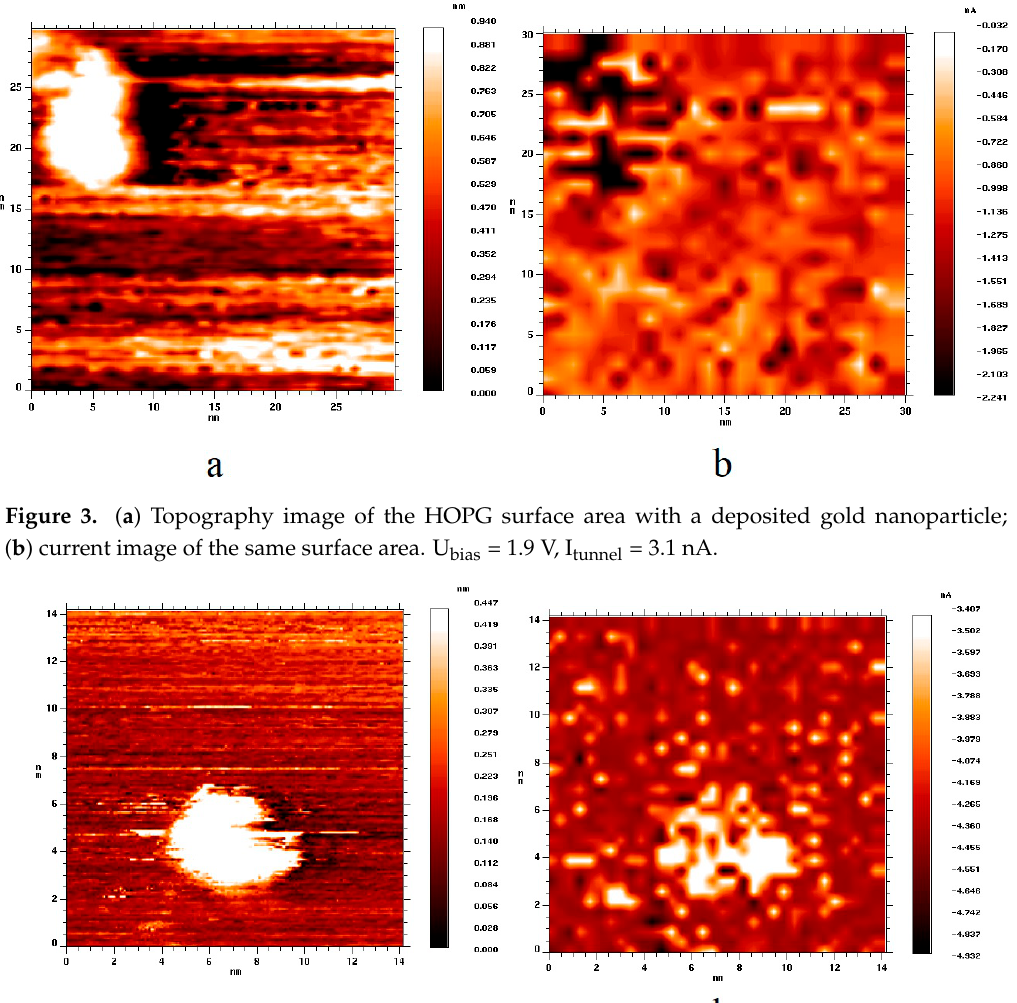
Figure 2. ( a , c ) Topography images of HOPG surface area containing a gold nanoparticle; ( b ) current image of the same surface area; ( d ) volt–ampere characteristic (VAC) of the tunneling currents, averaged over the surface areas indicated by the rectangles in Figure 2c. U bias = 2.1 V, I tunnel = 2.9 nA.